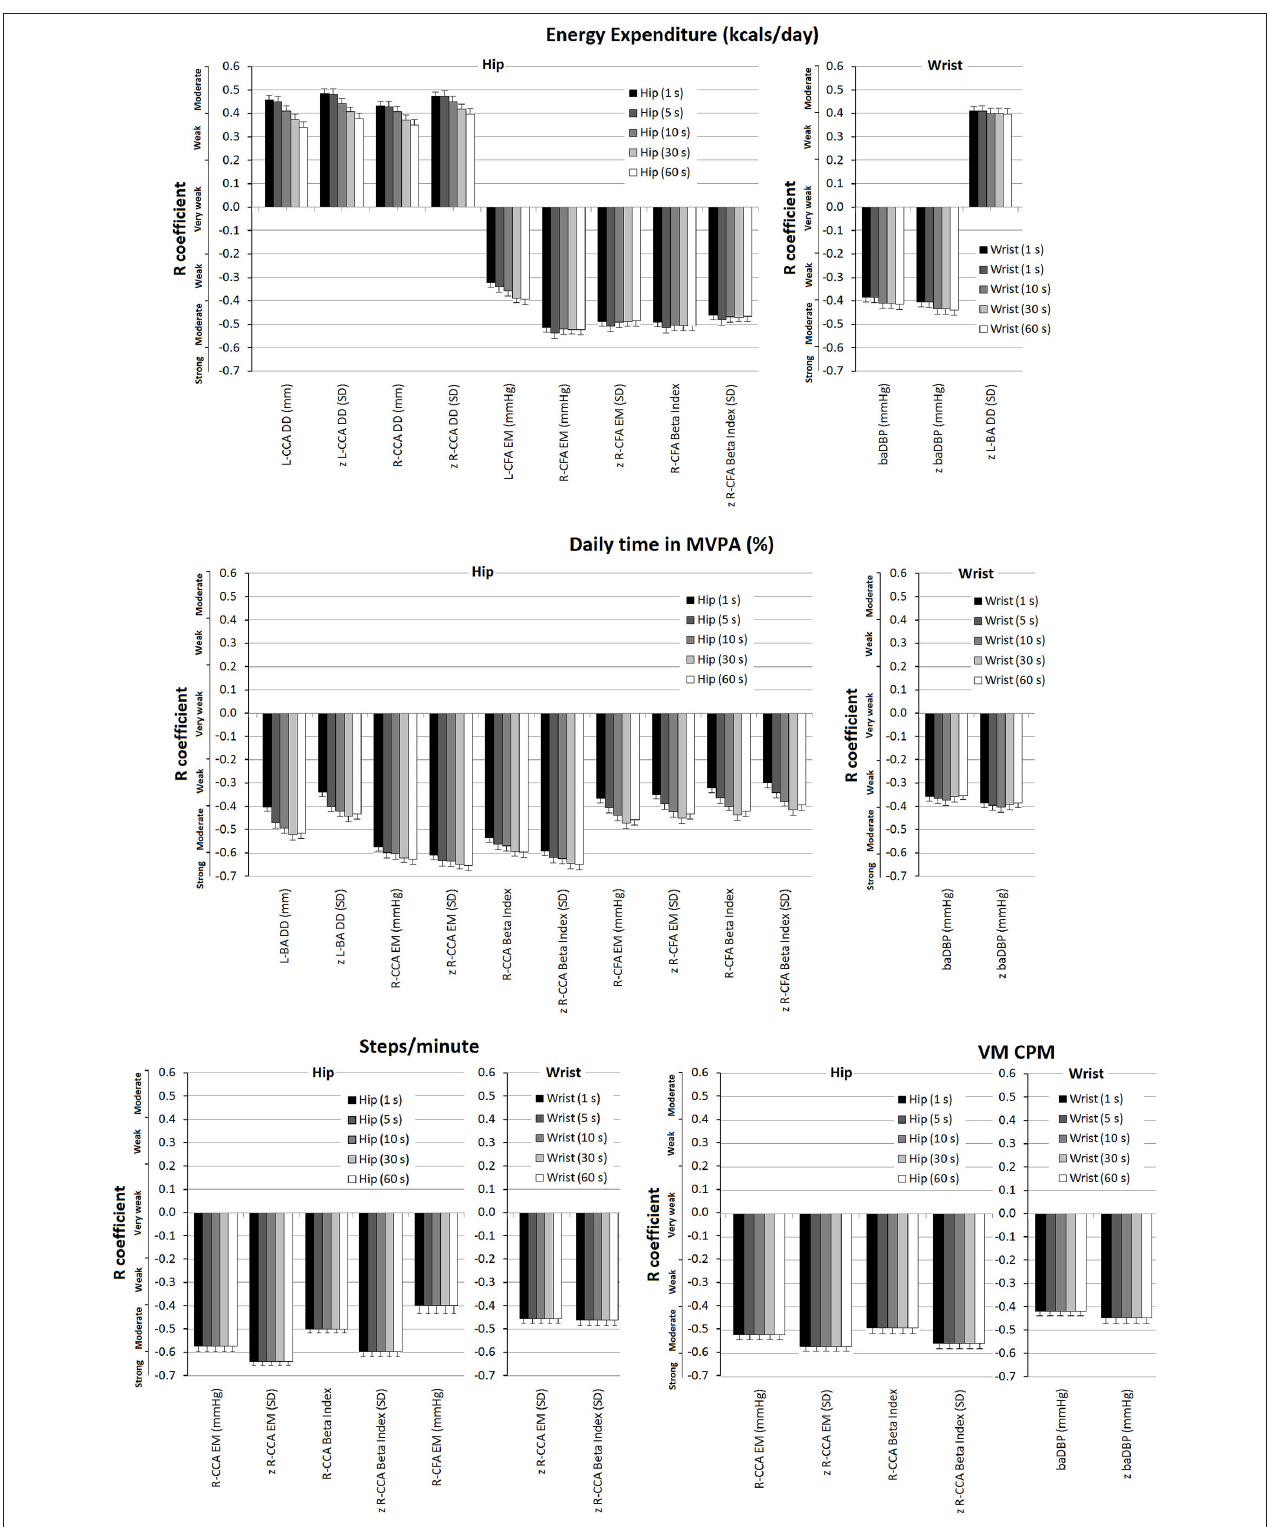
FIGURE 4 | Strength of association ( r coefficients; partial correlations) between accelerometry-derived physical activity indices and cardiovascular properties (measured levels and/or z-scores), for hip and/or wrist records, as a function of epoch length (1, 5, 10, 30, and 60s). Only the associations in which statistical significance was reached for at least one epoch are plotted. A more extensive description can be found in Supplementary Tables 25 – 28 in Supplementary Material 2 .